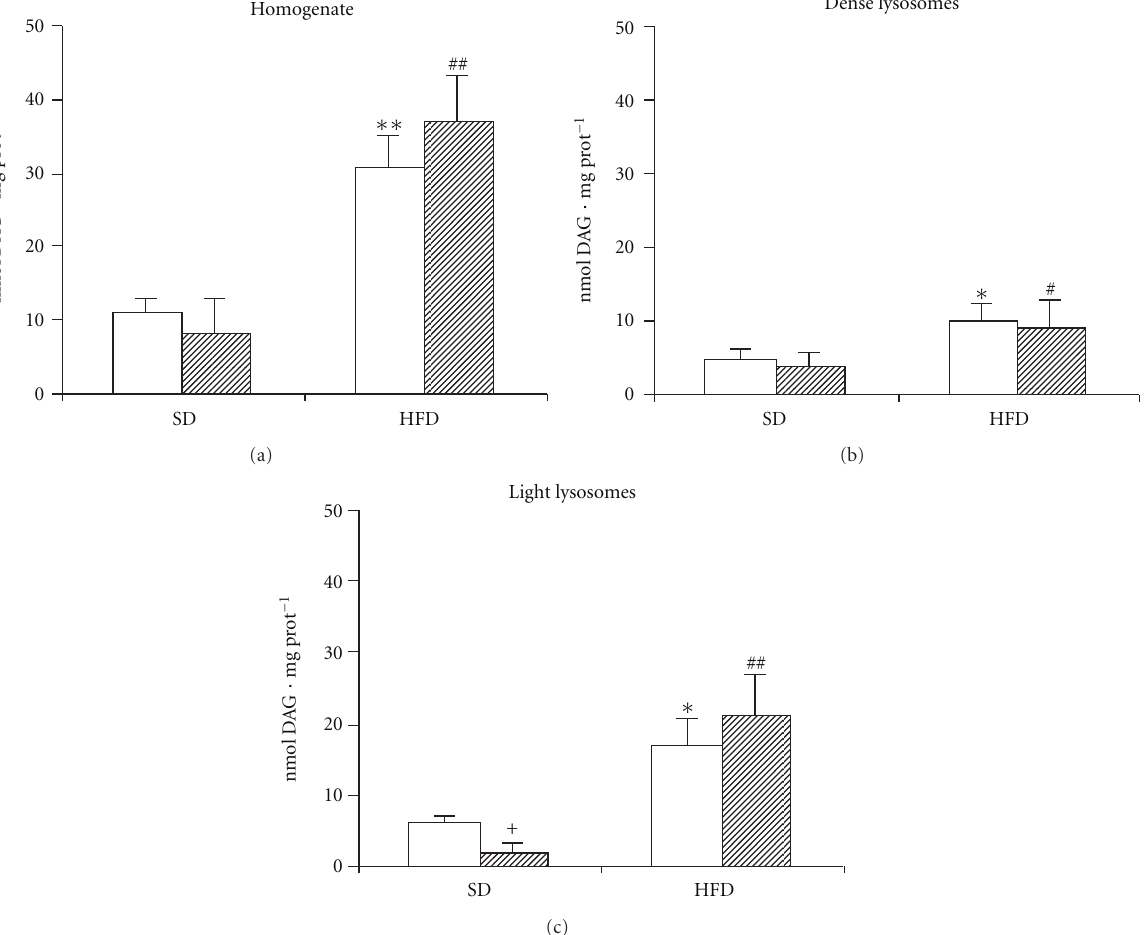
Figure 4: The e ff ect of HFD on the DAG production from intracellular TAG in vitro. (a) Homogenates; (b) dense lysosomes; (c) light lysosomes. 10% liver homogenate, dense lysosomal or light lysosomal fractions were incubated 60 min at pH = 4.5. At the end of incubation, DAG was extracted into chlorophorm-methanol and quantified as described in Section 2. The graph shows the di ff erence between DAG concentration in the sample at the beginning and at the end of the incubation. Open bars = fasted animals; hatched bars = fed animals. + P < 0 . 05 fed versus fasted; ∗ P < 0 . 05, ∗∗ P < 0 . 01 HFD fasted versus SD fasted; # P < 0 . 05, ## P < 0 . 01 HFD fed versus SD